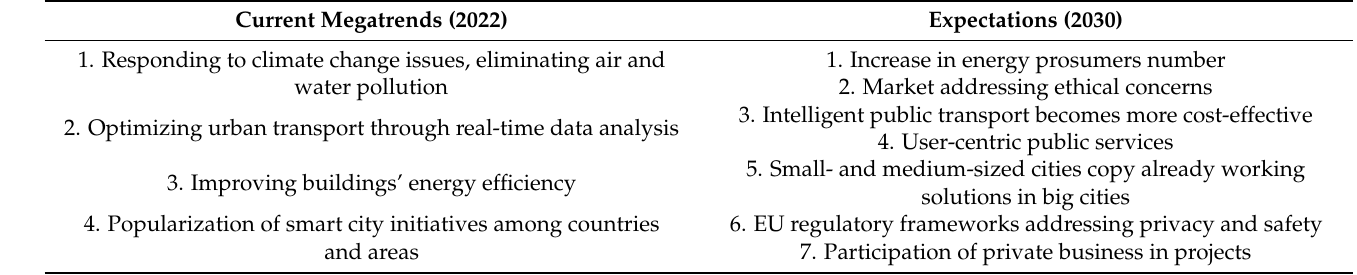
Table 1. Emerging trends in smart city infrastructure development,